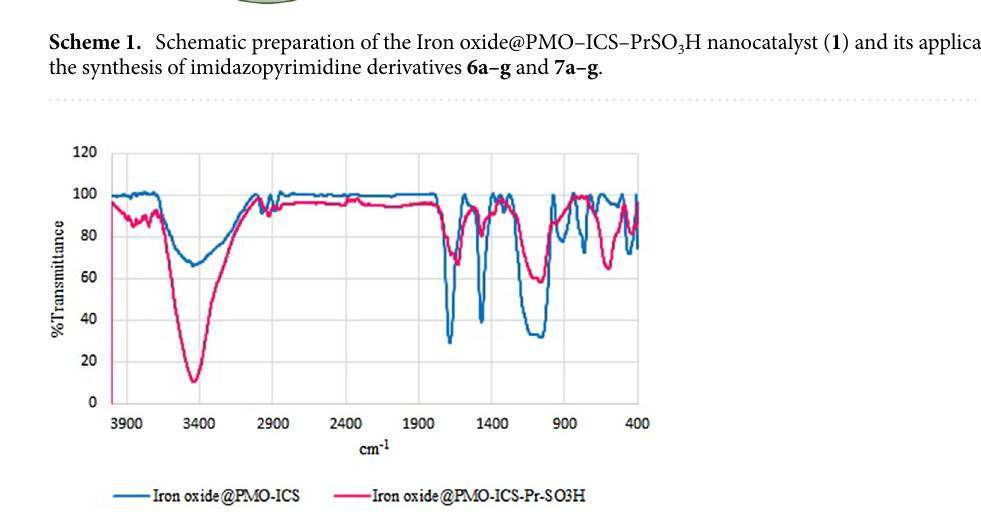
Figure 2. FT-IR spectra of PMO-ICS mesoporous catalyst (blue spectrum) and Iron oxide@PMO-ICS-PrSO 3 H magnetic mesoporous catalyst ( 1 , pink